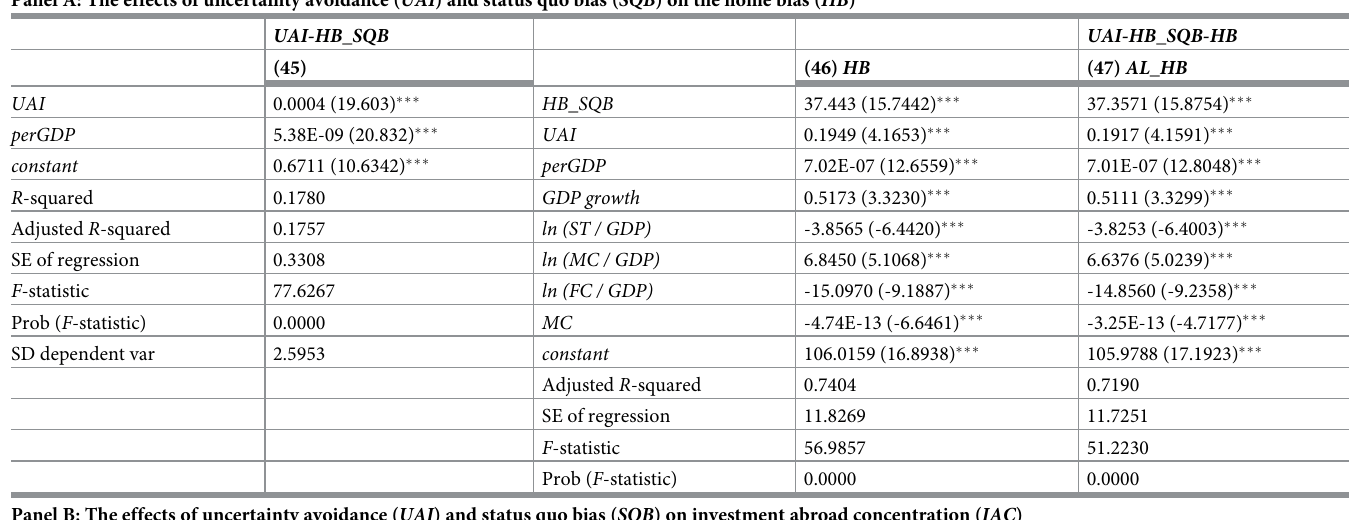
Table 8. The results of UAI-SQB and UAI-SQB-UNDV models. Panel A: The effects of uncertainty avoidance ( UAI ) and status quo bias ( SQB ) on the home bias ( HB )